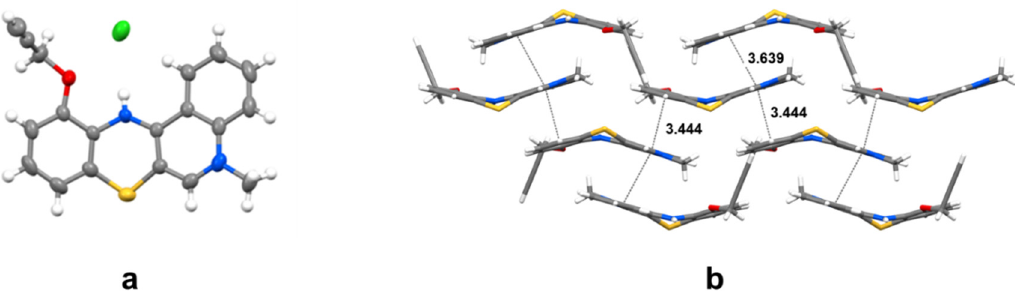
Figure 1. ( a ) Molecular structure of 11-propargyloxy-5-methyl-12 H -quinolino[3,4- b ][1,4]benzo thi- azinium chloride ( 6i ) (displacement ellipsoids for non-hydrogen atoms are drawn at a 50% probability level). ( b ) π – π stacking interactions in the crystal.